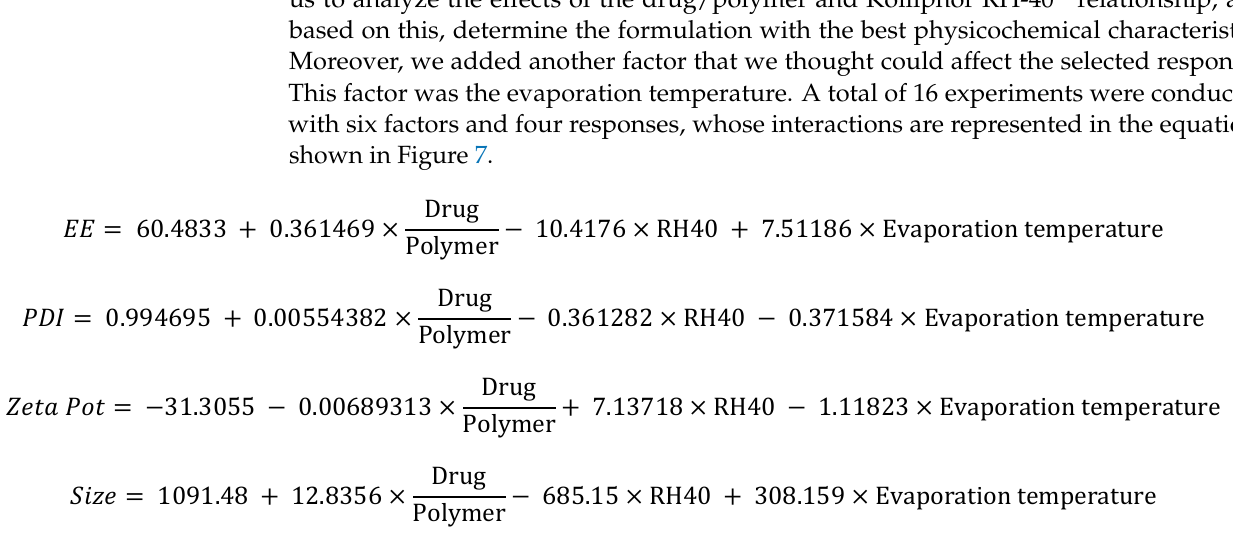
Figure 7. Interaction between factors for any response in the optimization phase. Based on the response surface graphs obtained after the optimization test (Figure 8), Table 7. Factors and responses established for optimization design. we decided to perform the physicochemical characterization tests.